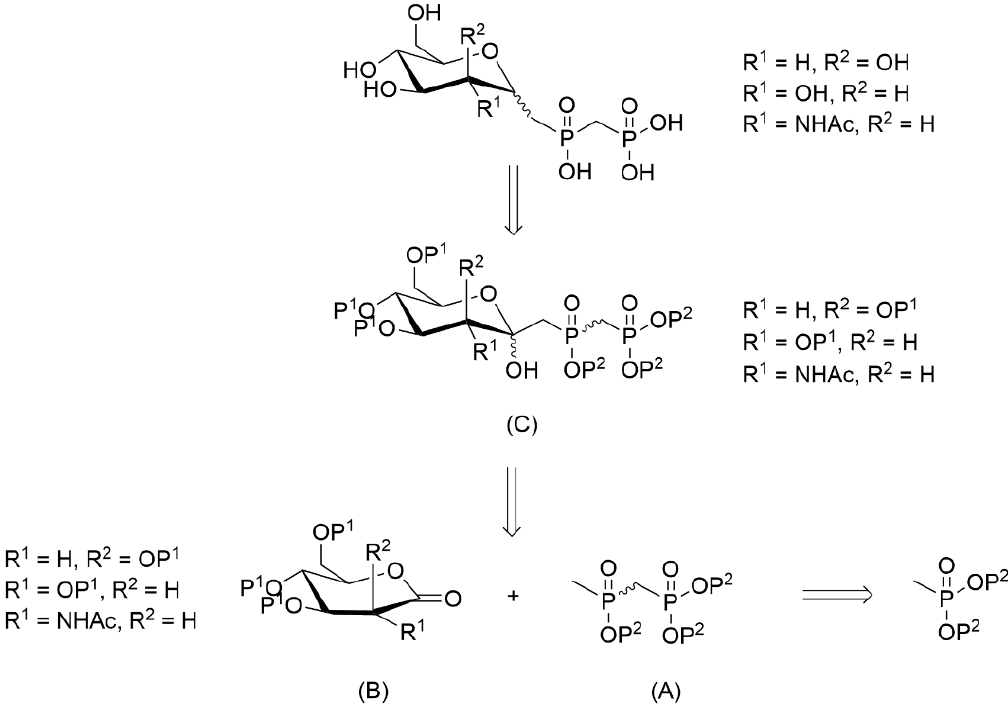
Figure 5. Retrosynthetic analysis.